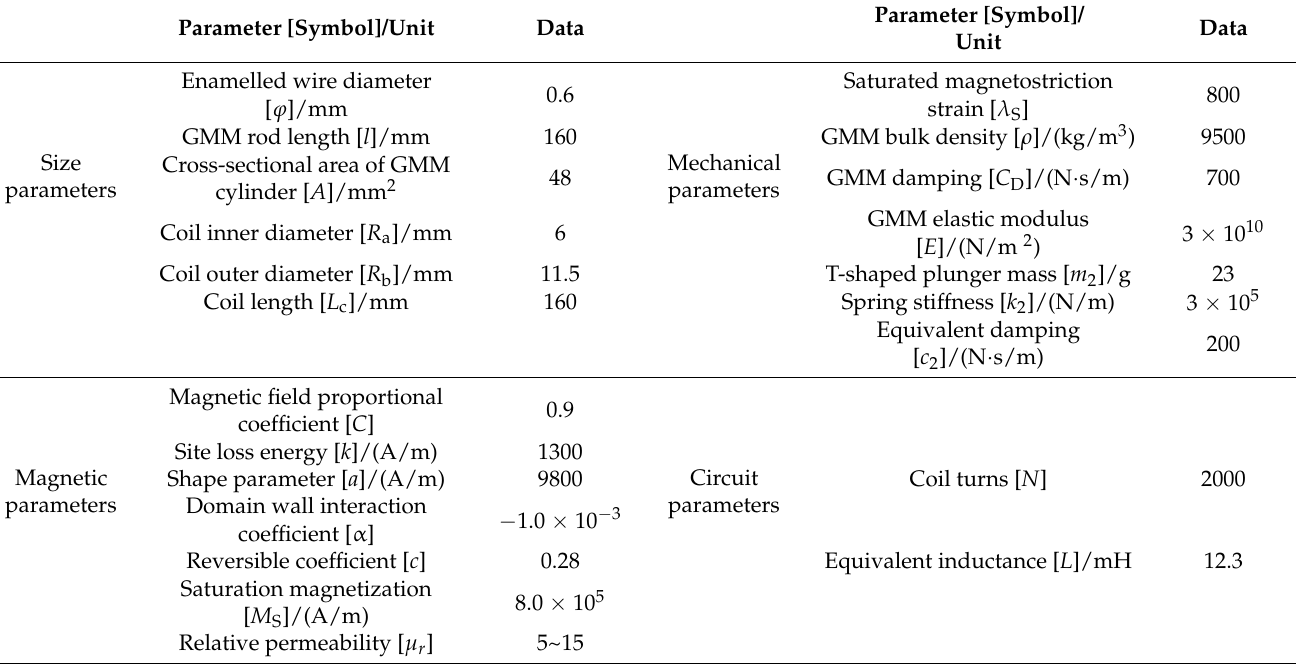
Table 1. GMA main